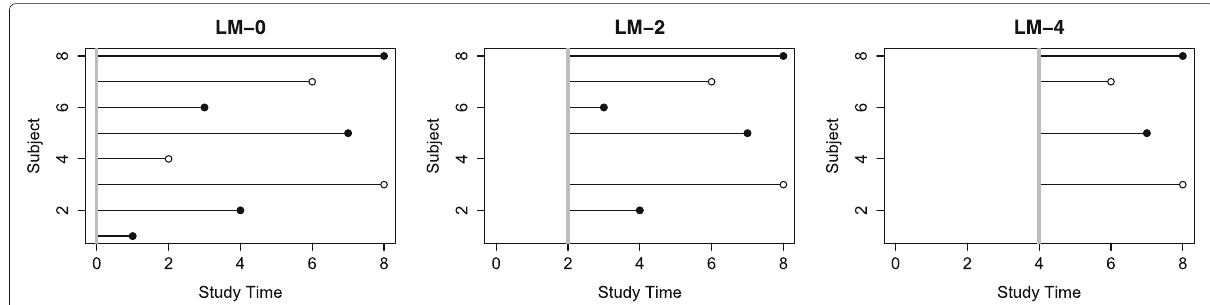
Fig. 1 An illustration of landmark analysis. Solid circles represent events, and hollow circles represent censored subjects. For each landmark time point, subjects still alive then are used for analysis. The solid vertical line represents the landmark analysis cutoff time